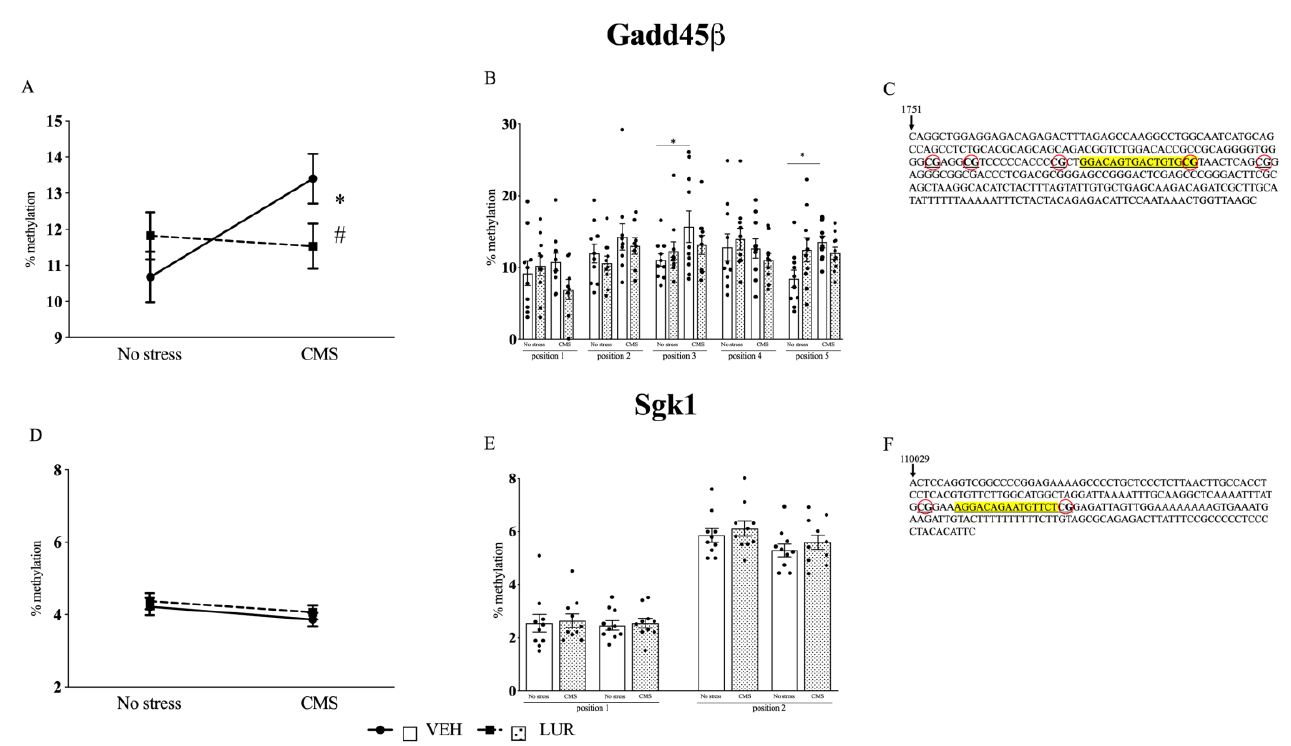
Figure 2. Analysis of Gadd45 β ( A , B ) and Sgk1 ( D , E ) DNA methylation in the prefrontal cortex of chronically stressed rats (CMS): Modulation by chronic lurasidone (LUR) treatment. Panel ( C – F ): Schematic representation of transcriptionally relevant CpG sites (surrounded in red) in Gadd45 β ( C ) and Sgk1 ( F ) in the vicinity of GRE (highlighted in yellow). The data, expressed as methylation percentage, are the mean ± SEM of the positions analyzed. * p < 0.05 No stress/VEH; # p < 0.05 vs. CMS/VEH (Two-way ANOVA with Tukey multiple comparison’s